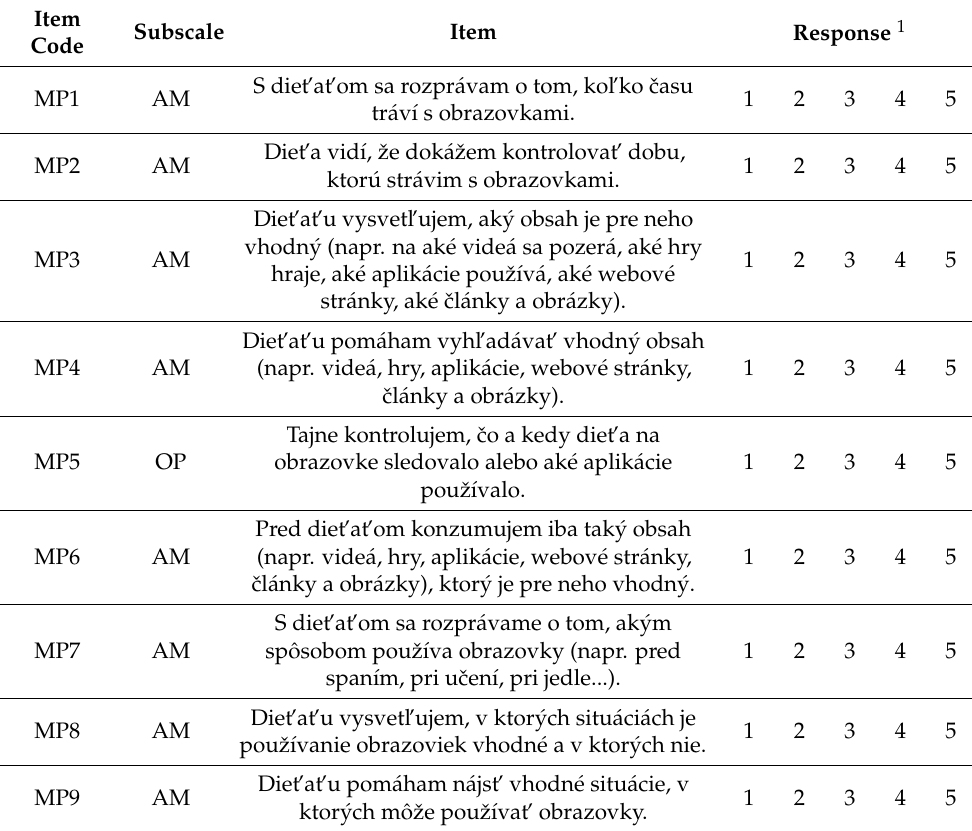
Table A6. MEPA-20: Slovak version.